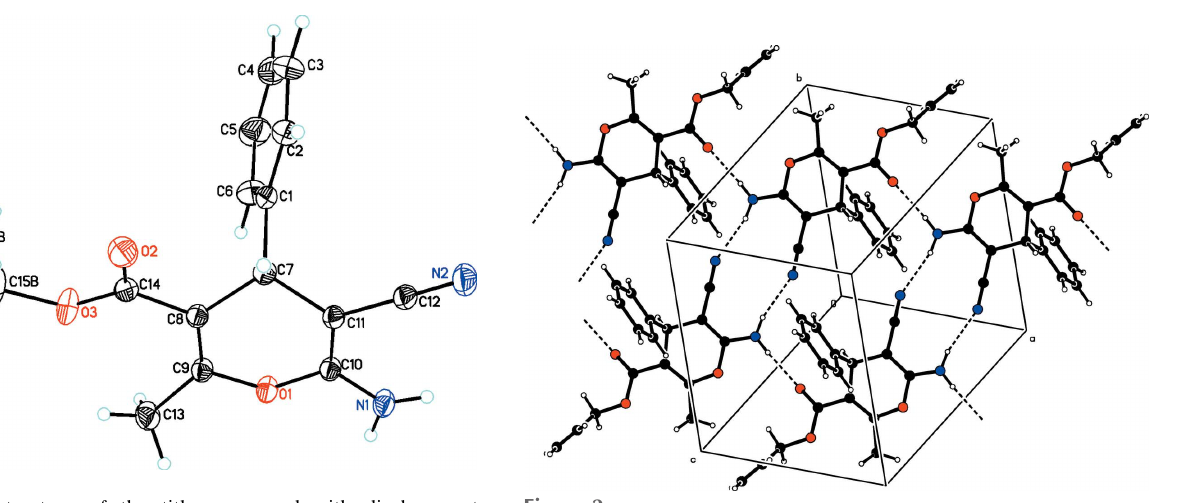
(Table 1) link the molecules, forming an infinite ribbon running along [100] (Fig. 2). The N—H (cid:2) (cid:2) (cid:2) N interactions form an R 2 (12) graph-set motif. 2